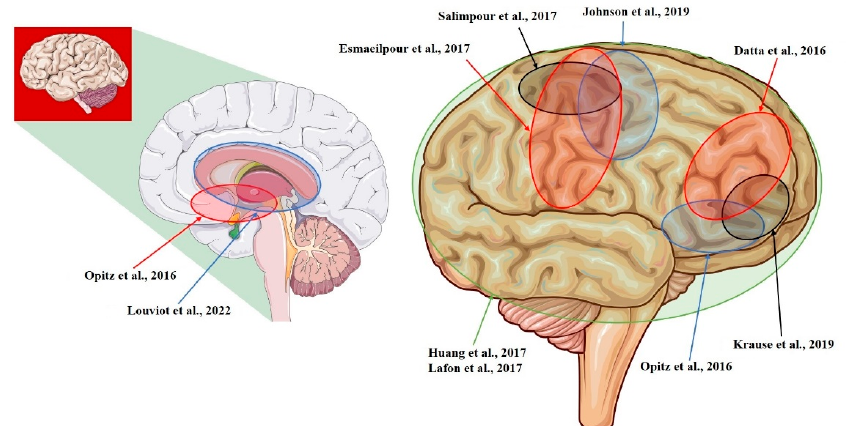
Figure 2. Sagittal section (left) and cerebral cortex (right) of the right hemisphere showing regions